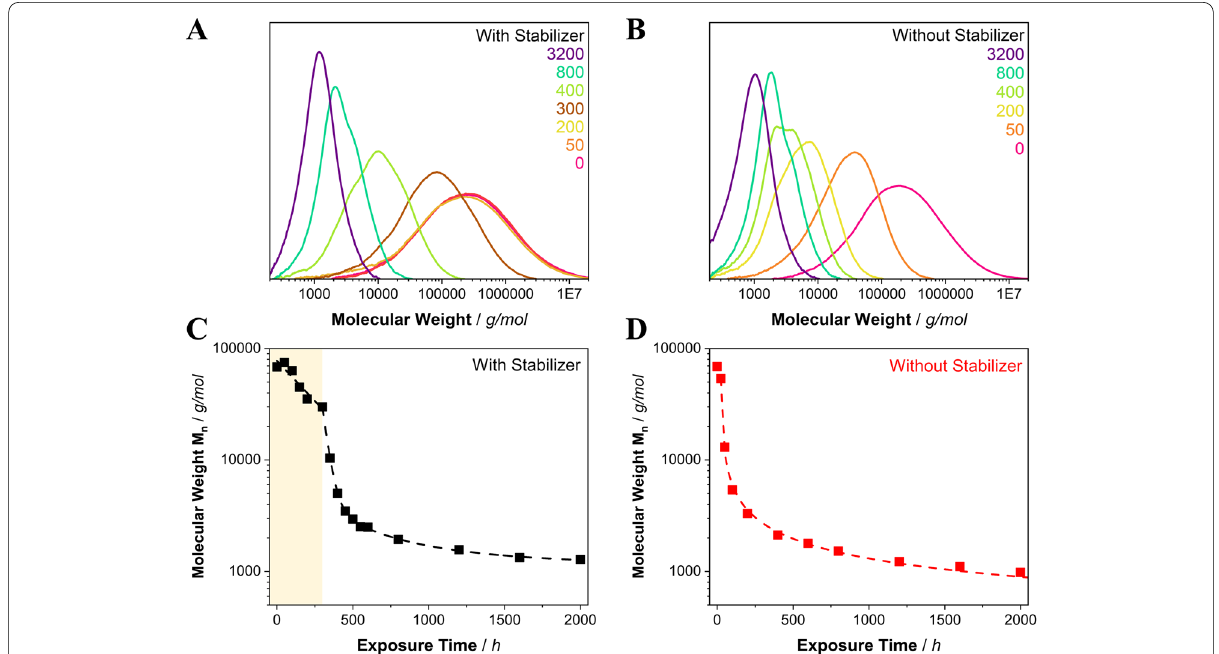
Fig. 2 Molecular weight distributions for A PP with additive and B PP without additive for chosen exposure time intervals. C M n as a function of exposure time for PP with and D without stabilizer. The induction phase is highlighted in